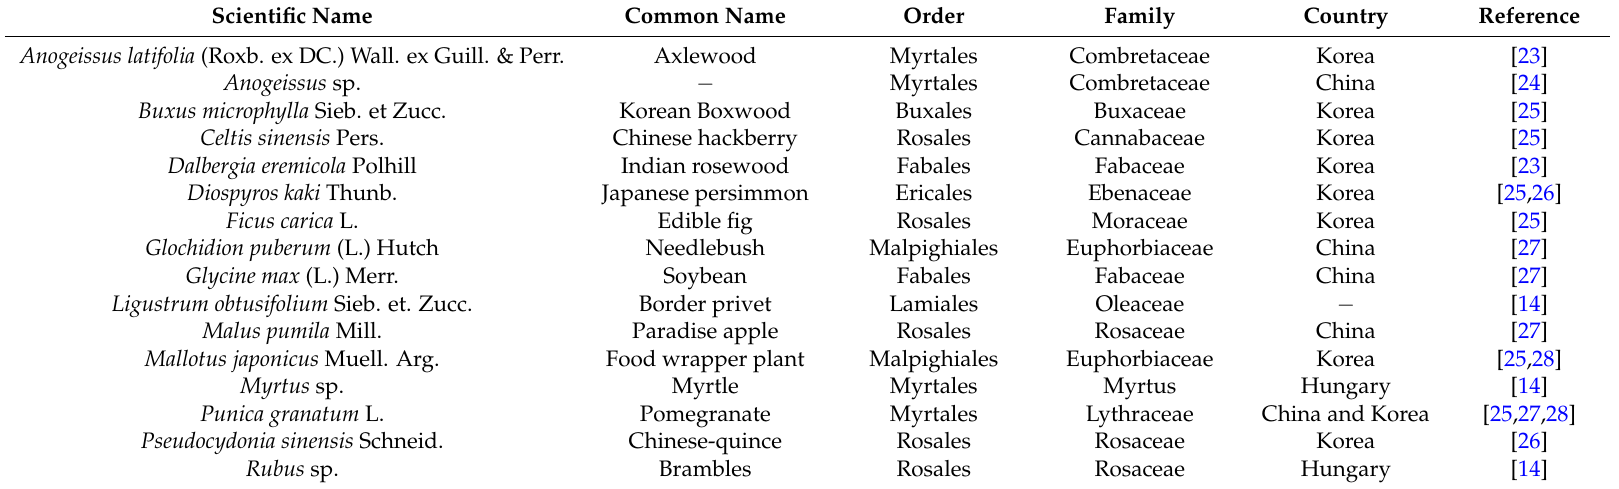
Table 1. Host plants of Acanthococcus lagerstroemiae in Asia and Hungary (except for Lagerstroemia